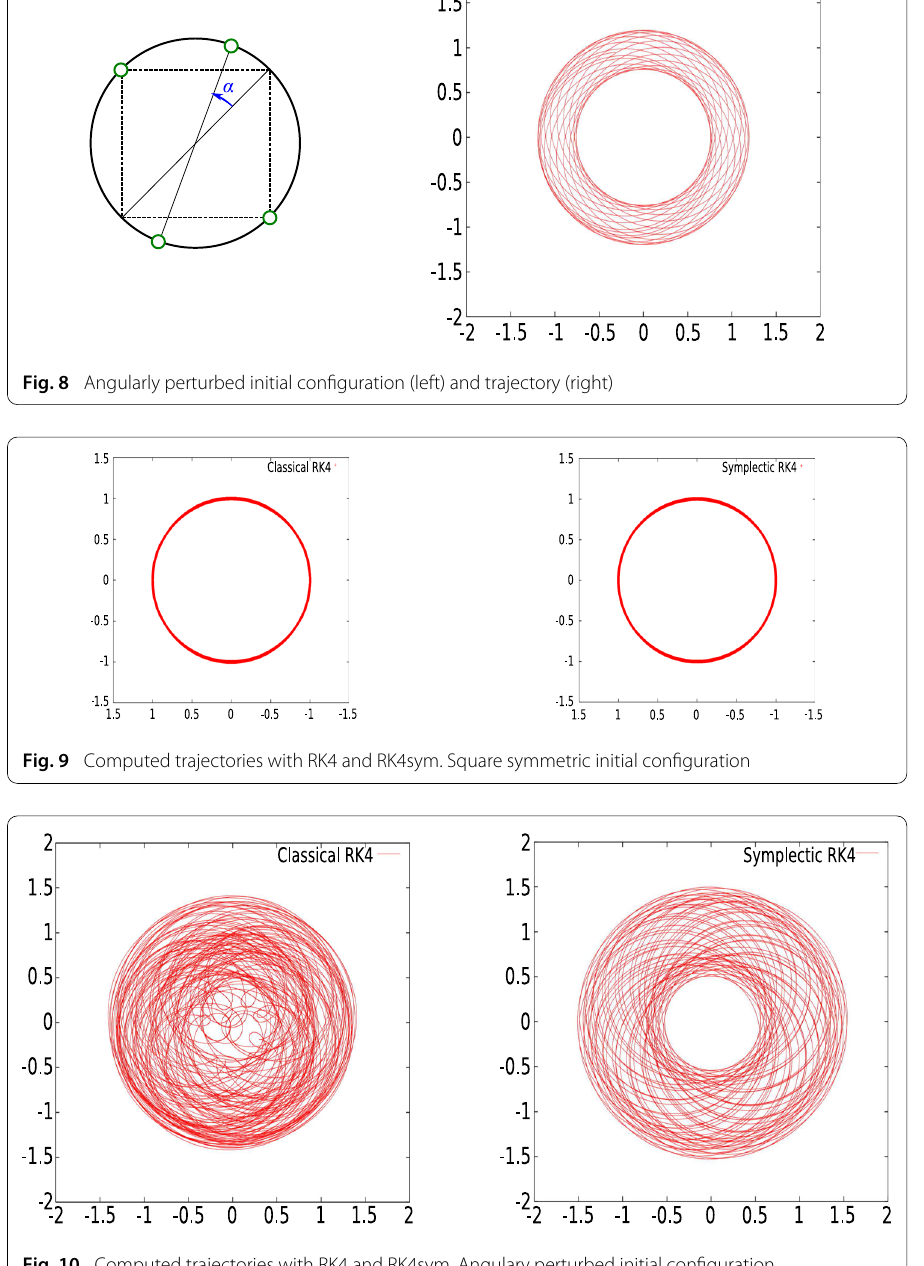
Multisymplectic